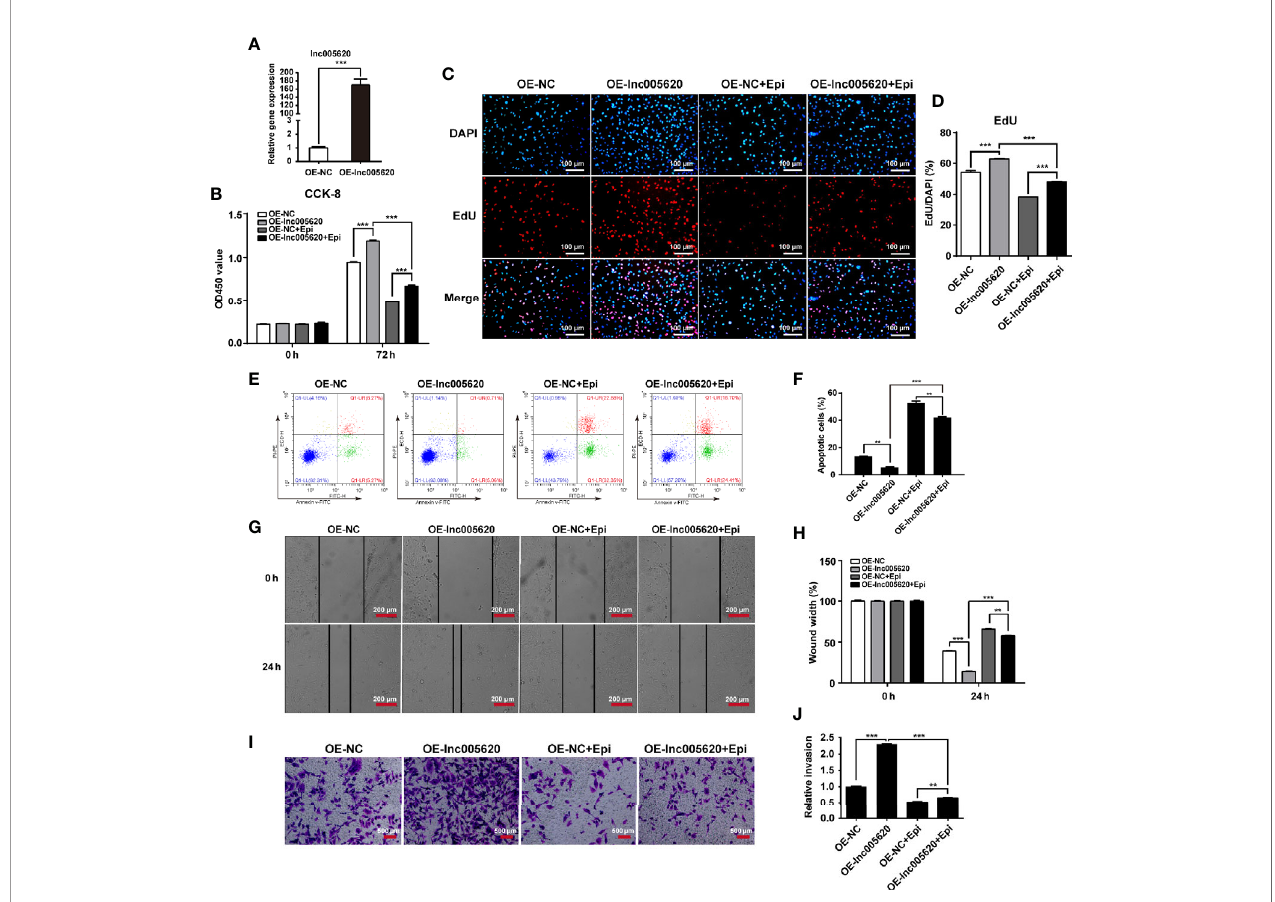
FIGURE 3 | lnc005620 promotes proliferation, invasion and epirubicin resistance in MDA-MB-231 cells. lnc005620 was overexpressed in native MDA-MB-231 cells treated with or without 12.5 ng/ml epirubicin. (A) RT-qPCR validation of lnc005620 expression. (B) Cell proliferation analysis by CCK-8 assay. (C) Cell proliferation analysis by EdU assay. DAPI for nuclei. Scale bars: 100 m m. (D) Quantitative analysis of EdU assay. (E) Flow cytometry analysis of cell apoptosis. (F) Quantitative analysis of apoptotic cell percentages. (G) Cell migration analysis by wound healing assay. Scale bars: 200 m m. (H) Quantitative analysis of cell migration. (I) Cell invasion analysis by Transwell assay. Scale bars: 500 m m. (J) Quantitative analysis of cell invasion. OE-NC, negative control; OE-lnc005620, overexpression of lnc005620; OE-NC+Epi, negative control and exposure to epirubicin; OE-lnc005620+Epi, overexpression of lnc005620 and exposure to epirubicin. n = 3. Data are represented as the mean ± SD, ** P < 0.01, *** P <